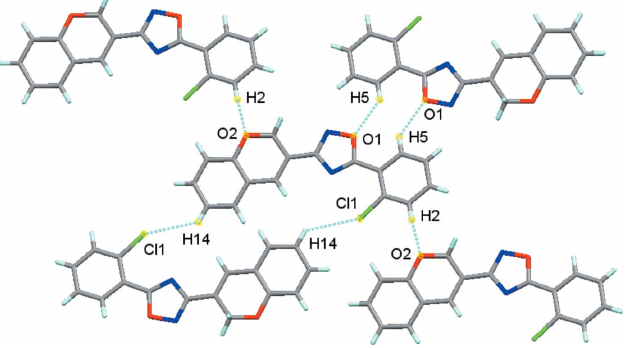
Figure 2 A view of two-dimensional sheet structure formed from C—H (cid:2)(cid:2)(cid:2) O and C—H (cid:2)(cid:2)(cid:2) Cl hydrogen bonds (cyan dotted lines).